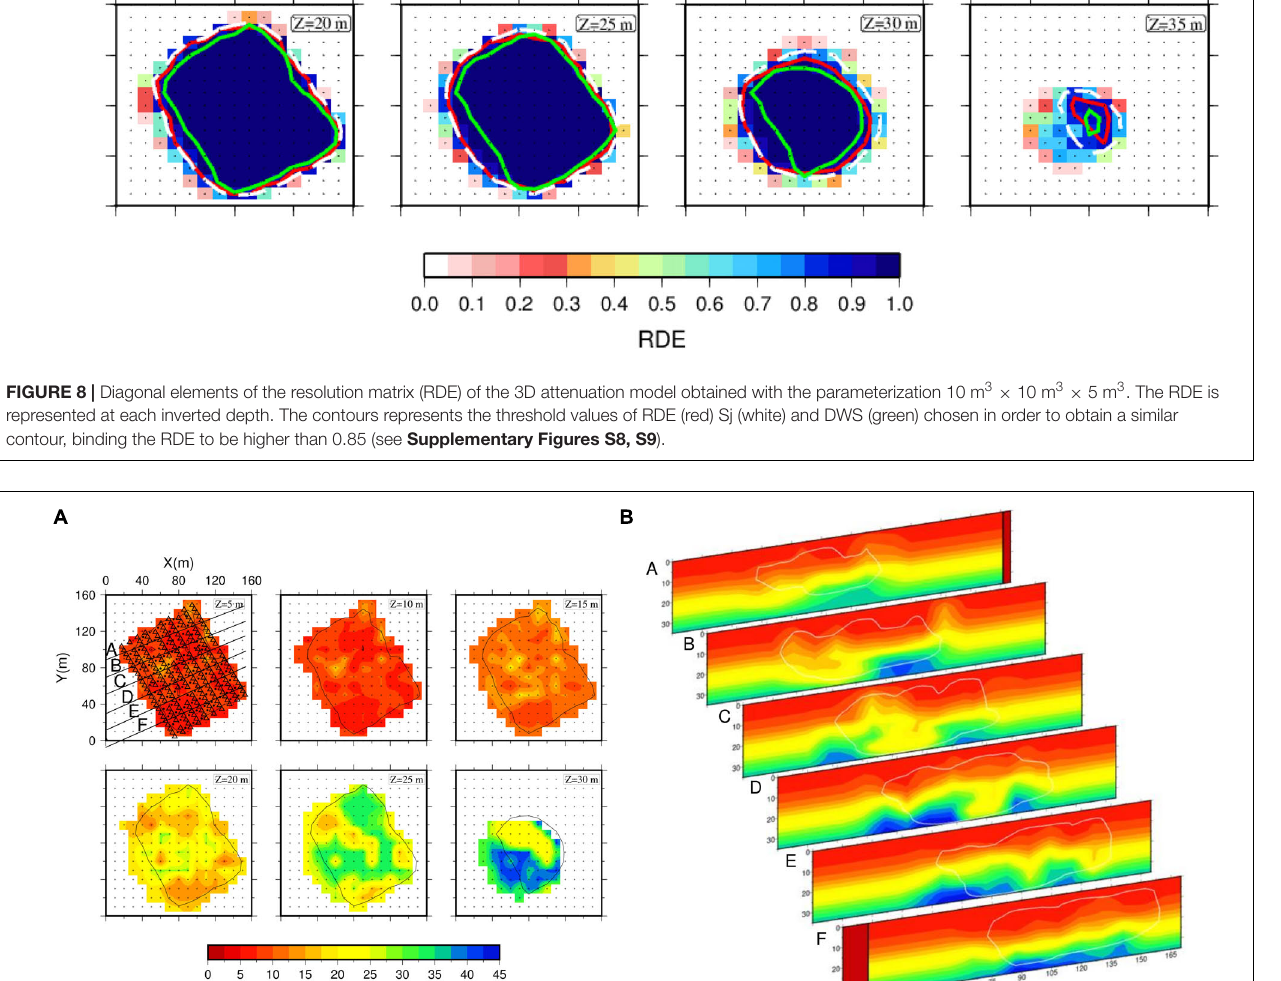
variations in six SW-NE sections (the black lines in Figure 9A ) crossing the tomographic model from NW to SE. The RMS value of retrieved model residuals shows a reduction of about 15% for